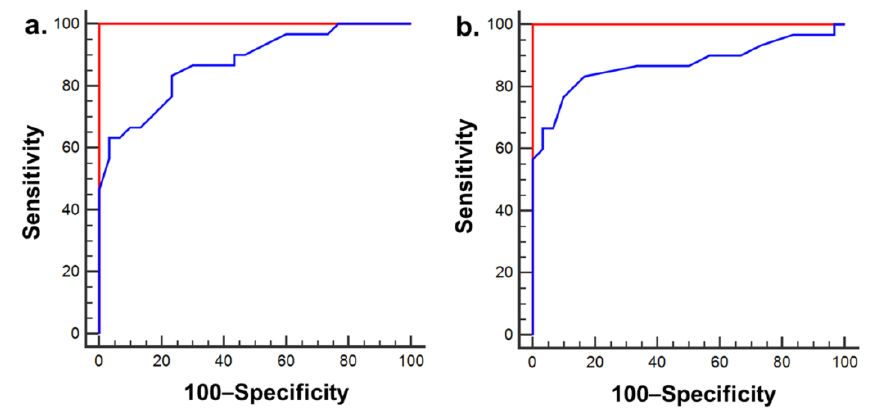
Figure 4. ROC curves of Lac + TG (red) and Cho (blue) metabolite concentration ratios for the differentiation between LC and HCC (a), and CLH and HCC (b). The AUC to distinguish HCC from LC was 1.00 (95% CI 0.94–1.00) ( p < 0.001) for Lac + TG and 0.88 (95% CI 0.76–0.95) ( p < 0.001) for Cho. Also, the AUC to distinguish HCC from CLH was 1.00 (95% CI 0.94–1.00) ( p < 0.001) for Lac + TG and 0.87 (95% CI 0.76–0.94) ( p < 0.001) for Cho. LC, liver cirrhosis without HCC; CLH, cirrhotic liver with HCC; HCC, hepatocellular carcinoma; Lac+TG, lactate+triglyceride; Cho, choline.